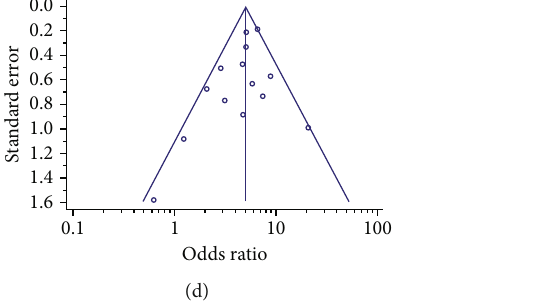
Figure 2: (a) Prevalence of smoking in severe COVID-19 patients. (b) Funnel plot for meta-analysis of the prevalence of smoking in severe COVID-19 patients. (c) Prevalence of smoking among severe COVID-19 patients after the exclusion of studies by Qi et al. [16] and Zhang et al. [23]. (d) Funnel plot for the meta-analysis of smoking among severe COVID-19 patients after the exclusion of studies by Qi D et al. [16] and Zhang R et al.